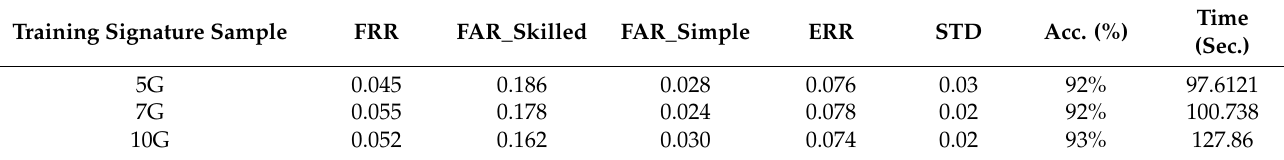
Table 9. Results of the proposed model on the UTSIG database.